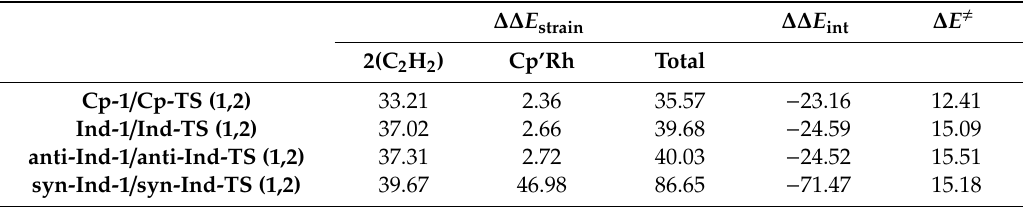
Table 1. Activation strain analysis for the oxidative coupling Z-1 → Z-2 (Path I); all values are in kcal mol − 1 . The fragments are Cp’Rh (Cp’ = Cp, Ind, and anti-[Cr(CO) 3 Ind]) and the C 4 H 4 moiety (the reference are two acetylene molecules).